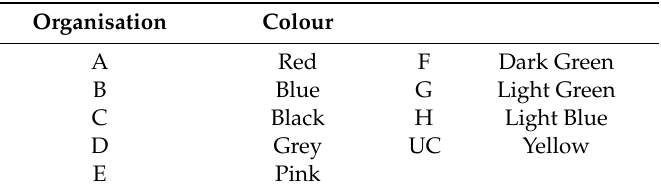
Table 1. Colors of Organisations in Figure 2.